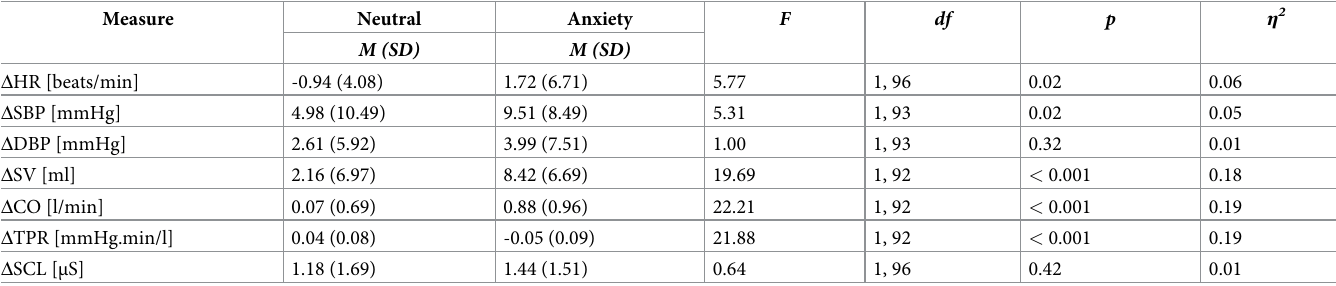
Note. Δ = measures reported as the difference scores relative to baseline. HR = heart rate, SBP = systolic blood pressure, DBP = diastolic blood pressure, SV = stroke volume, CO = cardiac output, TPR = total peripheral resistance, SCL = skin conductance